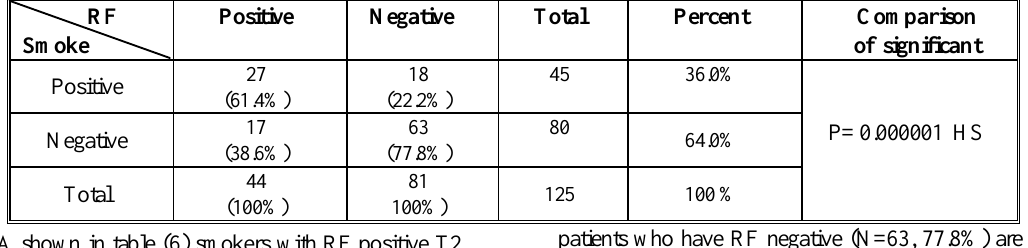
Table 6: Distribution of smokers among diabetic patients with either RF positive or RF negative results RF Positive Negative Total Percent Comparison Smoke Positive